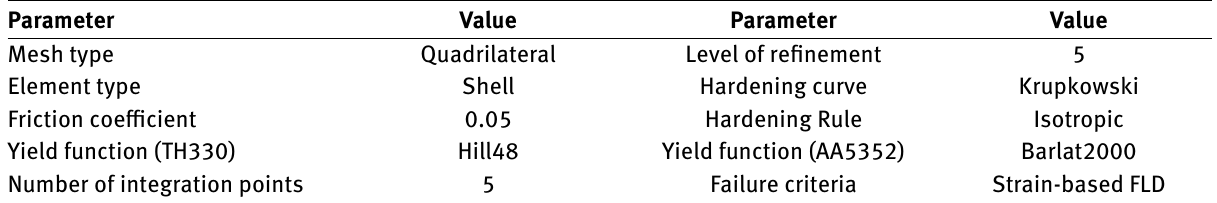
Table 4: Parameters defined in FEM software Parameter Value Parameter Value Mesh